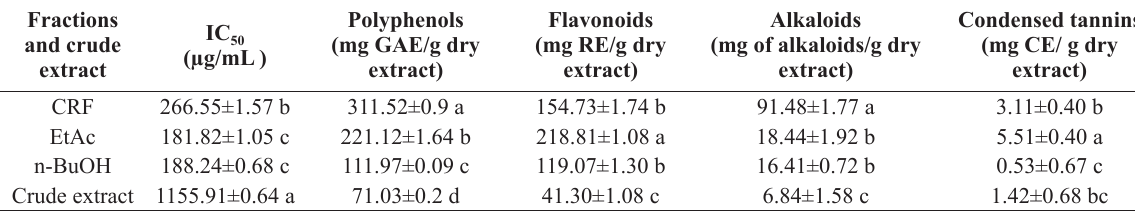
IC and total of polyphenols, flavonoids, alkaloids and condensed tannins 50 in the crude extract and in the fractions of fruits of T. catharinensis . Results are expressed as mean of three determinations ± RSD (relative standard deviation); averages followed by different letters in each column differ by Tukey test at p <